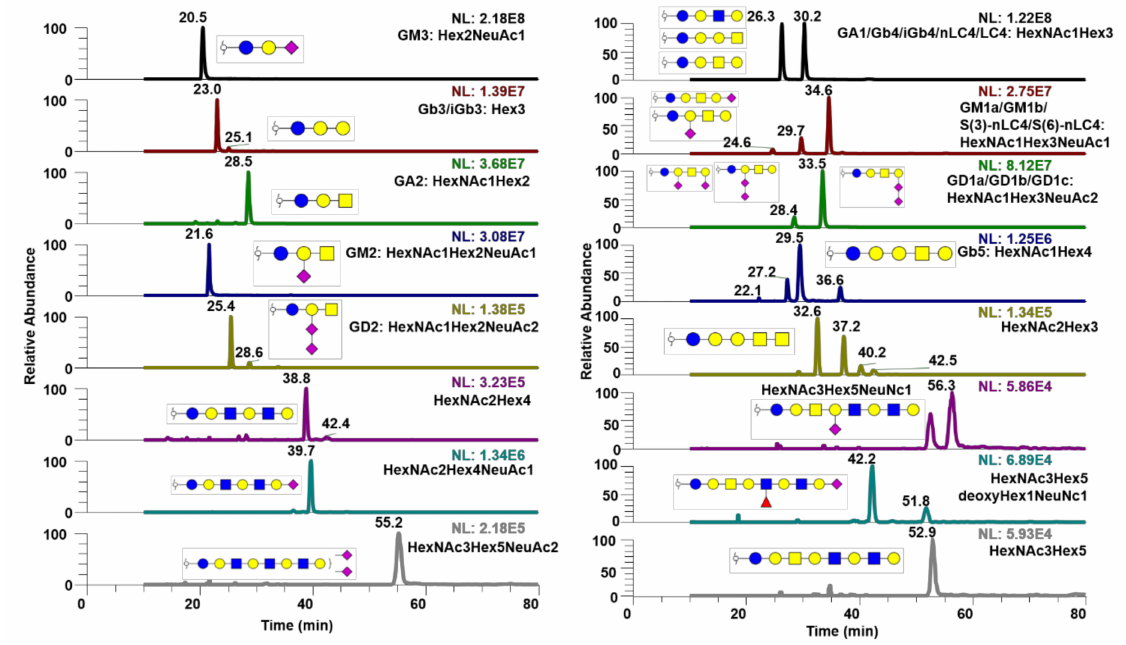
Figure 7. EIC of various glycosphingolipid (GSL) glycans derived from the 231BR cell line. Isomers of GSL-glycans are depicted with captions of their possible identity. MS2 spectra of the displayed structures were depicted in Figures